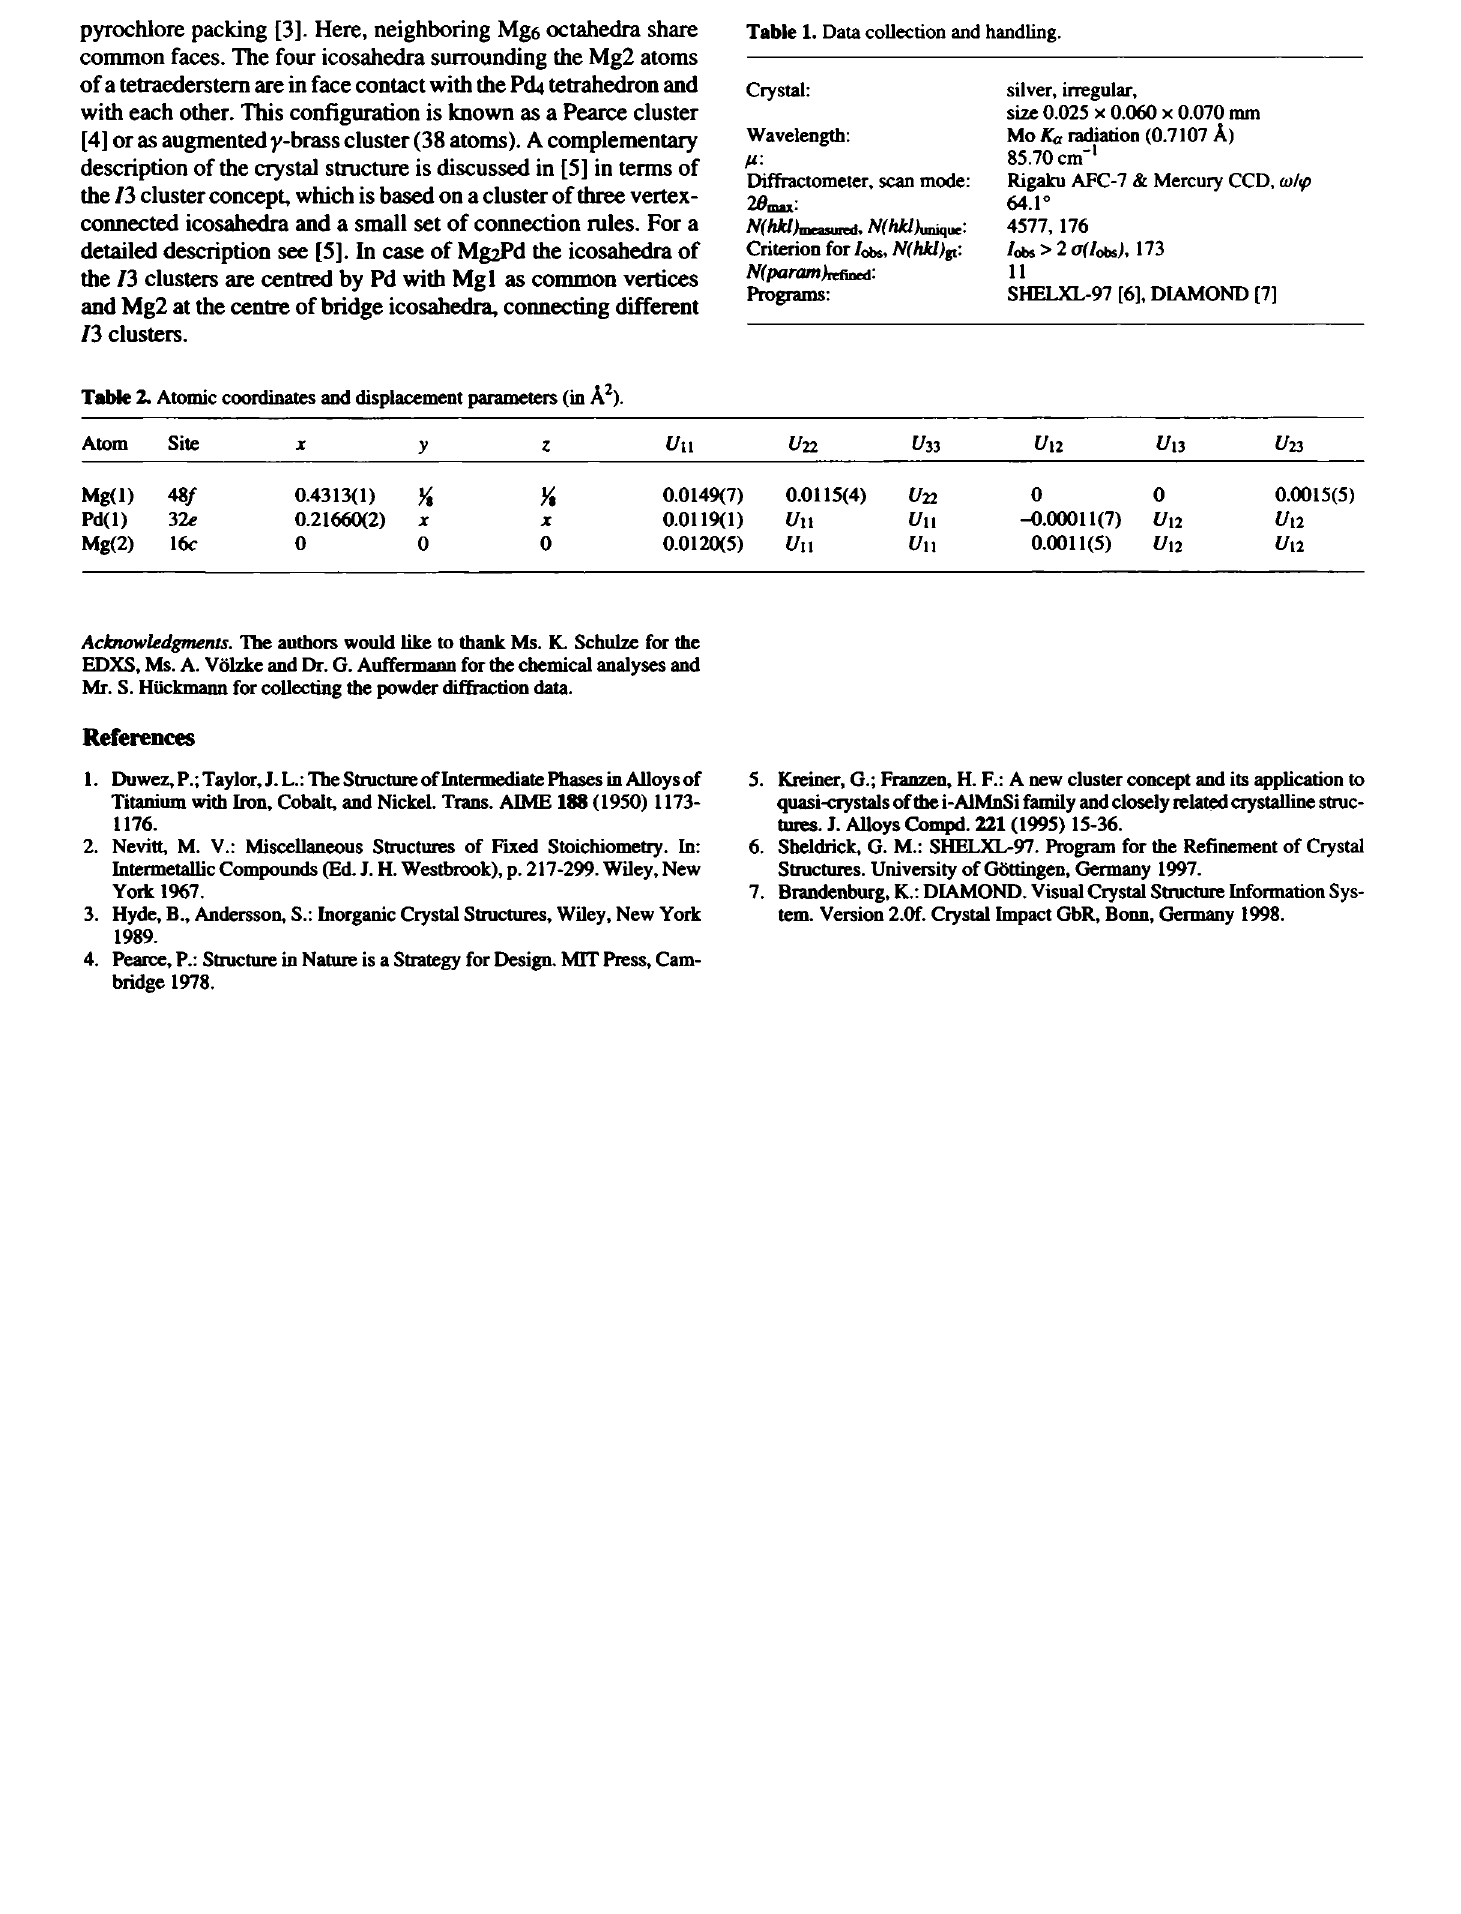
Table 1. Data collection and handling.